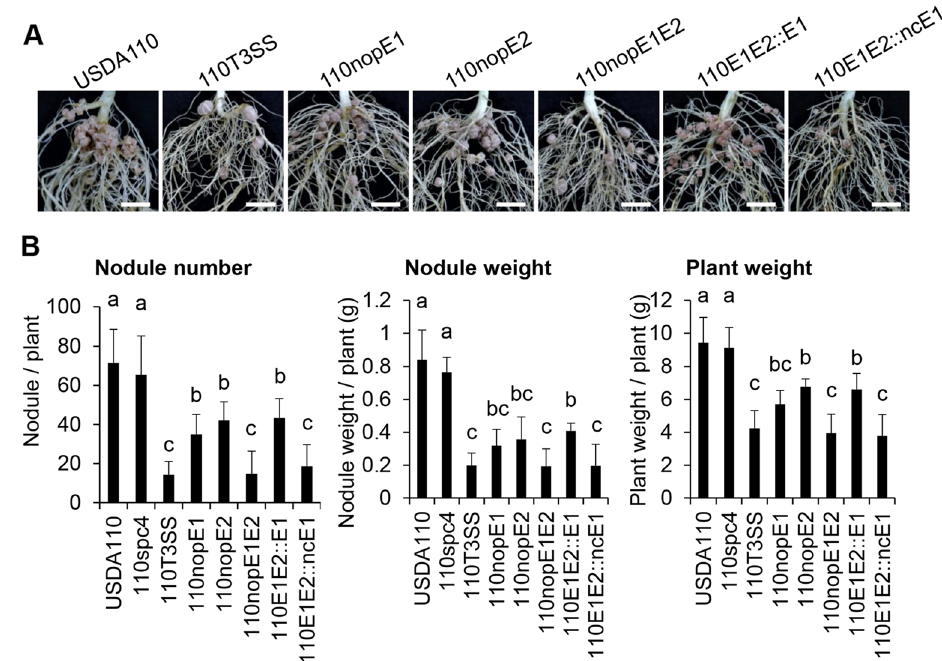
Figure 1. Roots (A) and symbiotic properties (B) of Vigna radiata cv. KPS1 inoculated with B. diazoefficiens and its mutant strains. Scale bars: 1 cm. The data shown are the means of at least 9 to 12 plants from two to three independent inoculation assays at 35 dpi. The error bars indicate the standard deviations. The means followed by different letters are significantly different at the 5% level ( P ≤ 0.05 according to Tukey’s